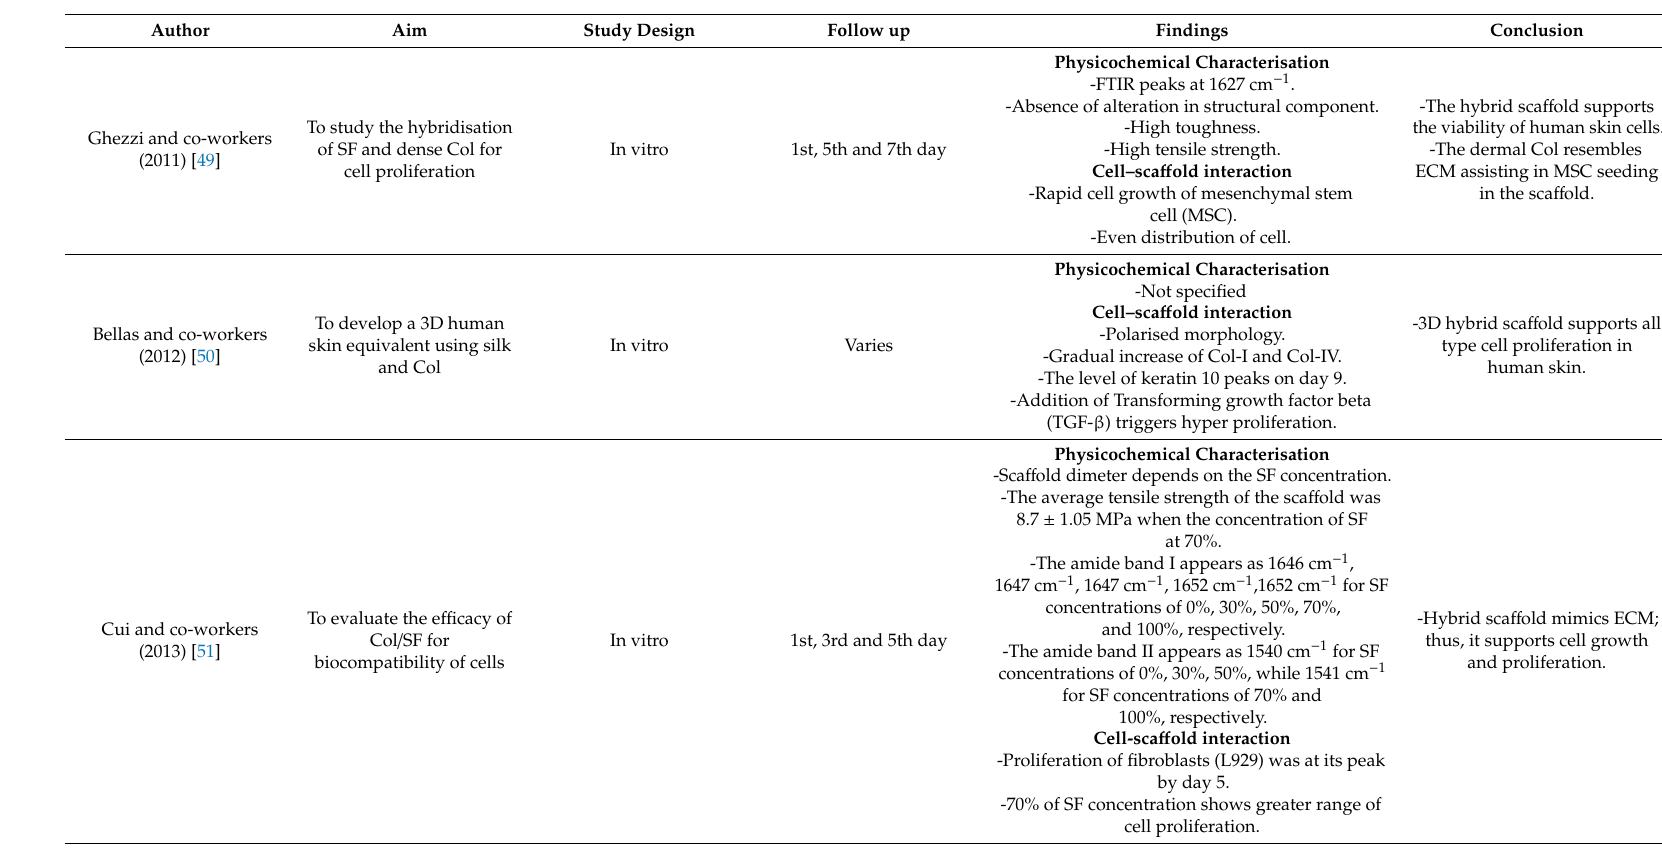
Table 1. E ff ects of hybrid of silk fibroin and collagen in cutaneous wound healing: in vitro and in vivo analysis. FTIR: Fourier transformation infrared